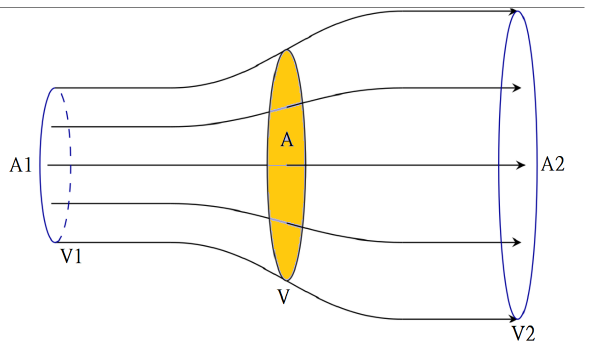
Figure 1. Schematic of fluid flow through a disk-shaped actuator. For a constant density fluid, the cross-sectional area varies inversely with